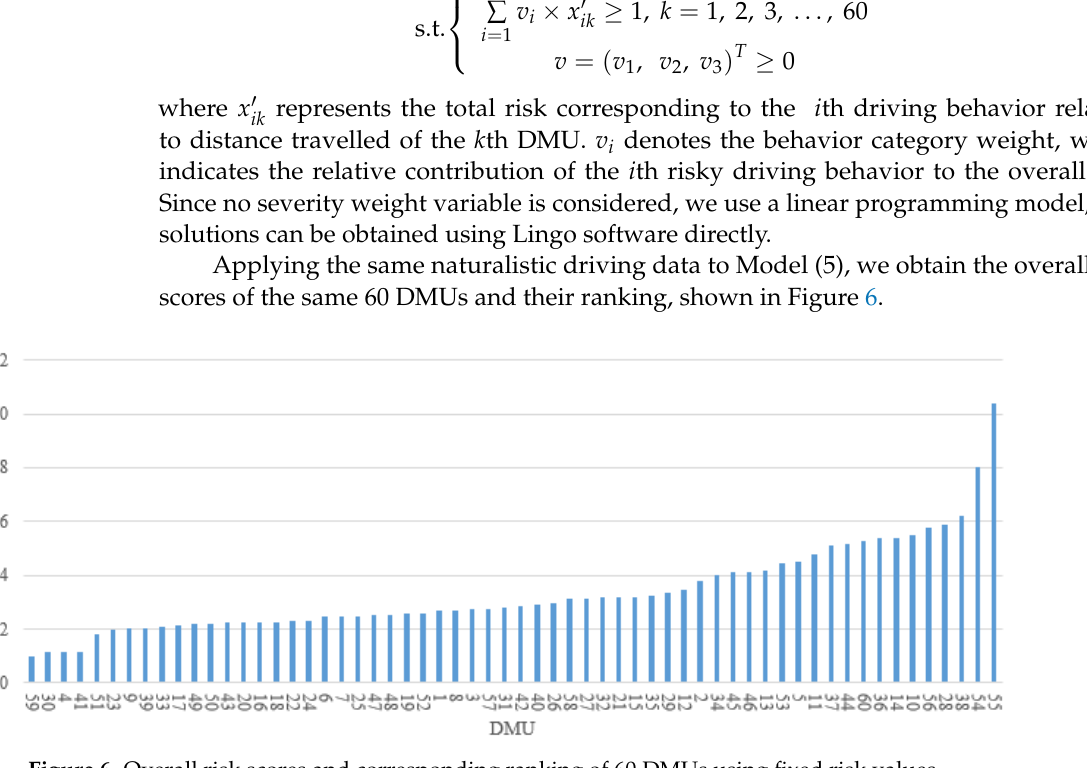
Figure 6. Overall risk scores and corresponding ranking of 60 DMUs using fixed risk values.